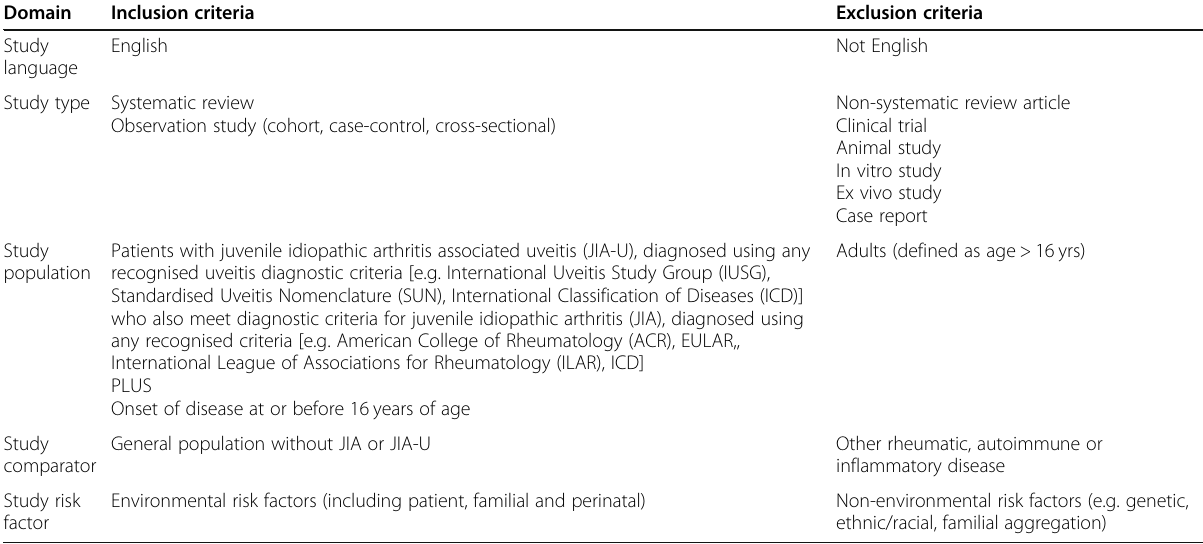
Table 2 Inclusion and exclusion criteria for studies